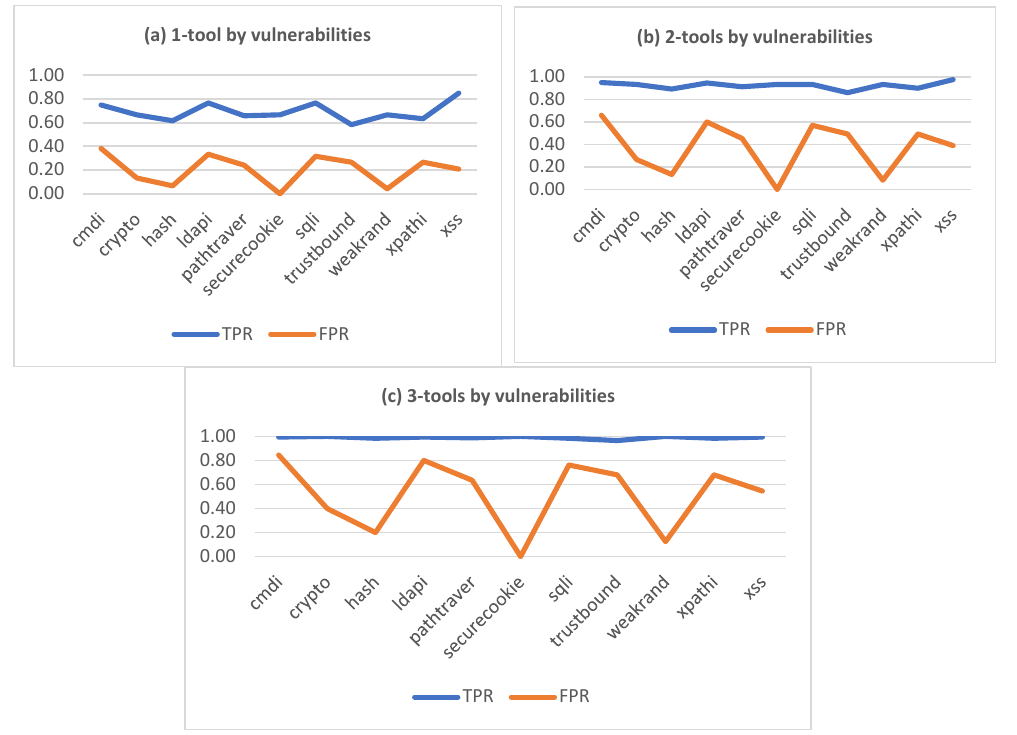
Figure 3. Average effectiveness considering n-tools combinations for each type of vulnerability.